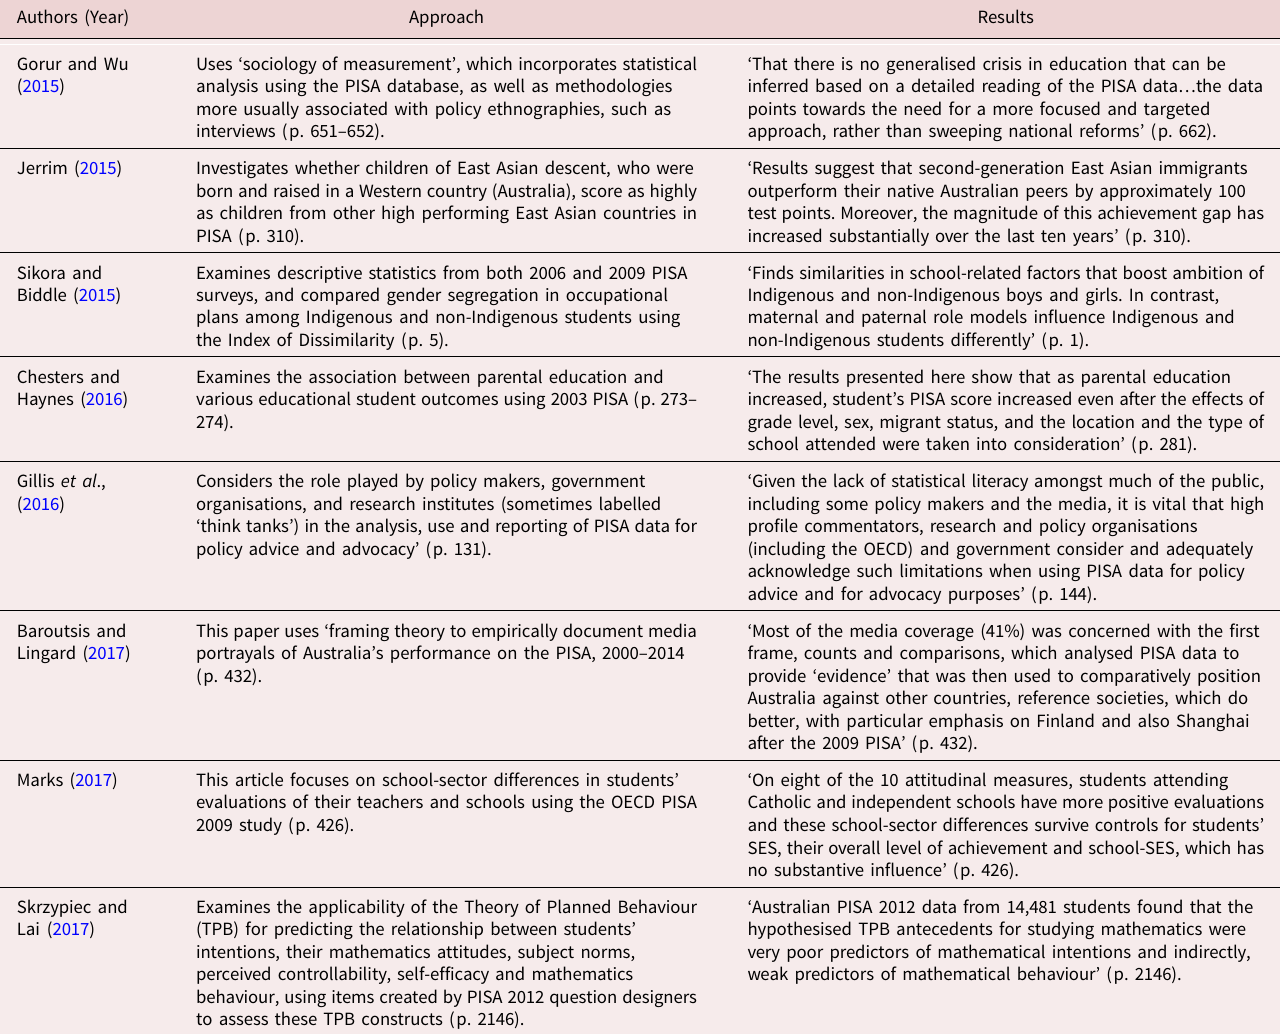
Table 1. The eight peer reviewed journal articles published since the 2015 round of